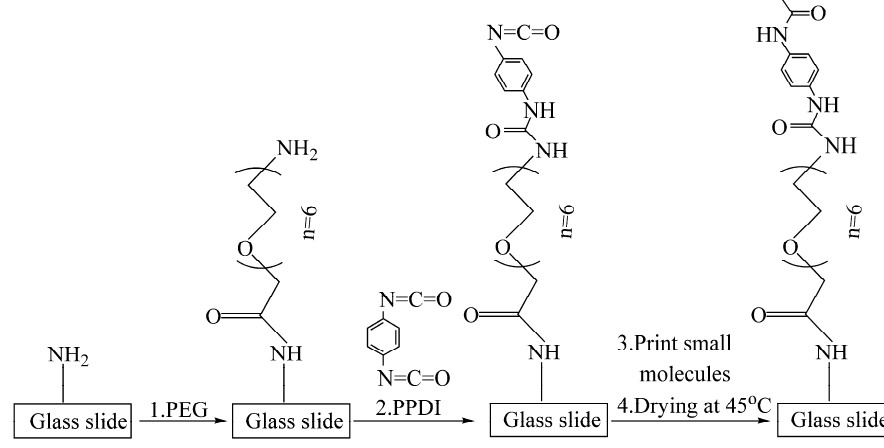
Figure 1. Steps of chemical modification of an amine functionalized glass slide to produce an isocyanate functionalized slide for SMM fabrication. functionalized slide for SMM